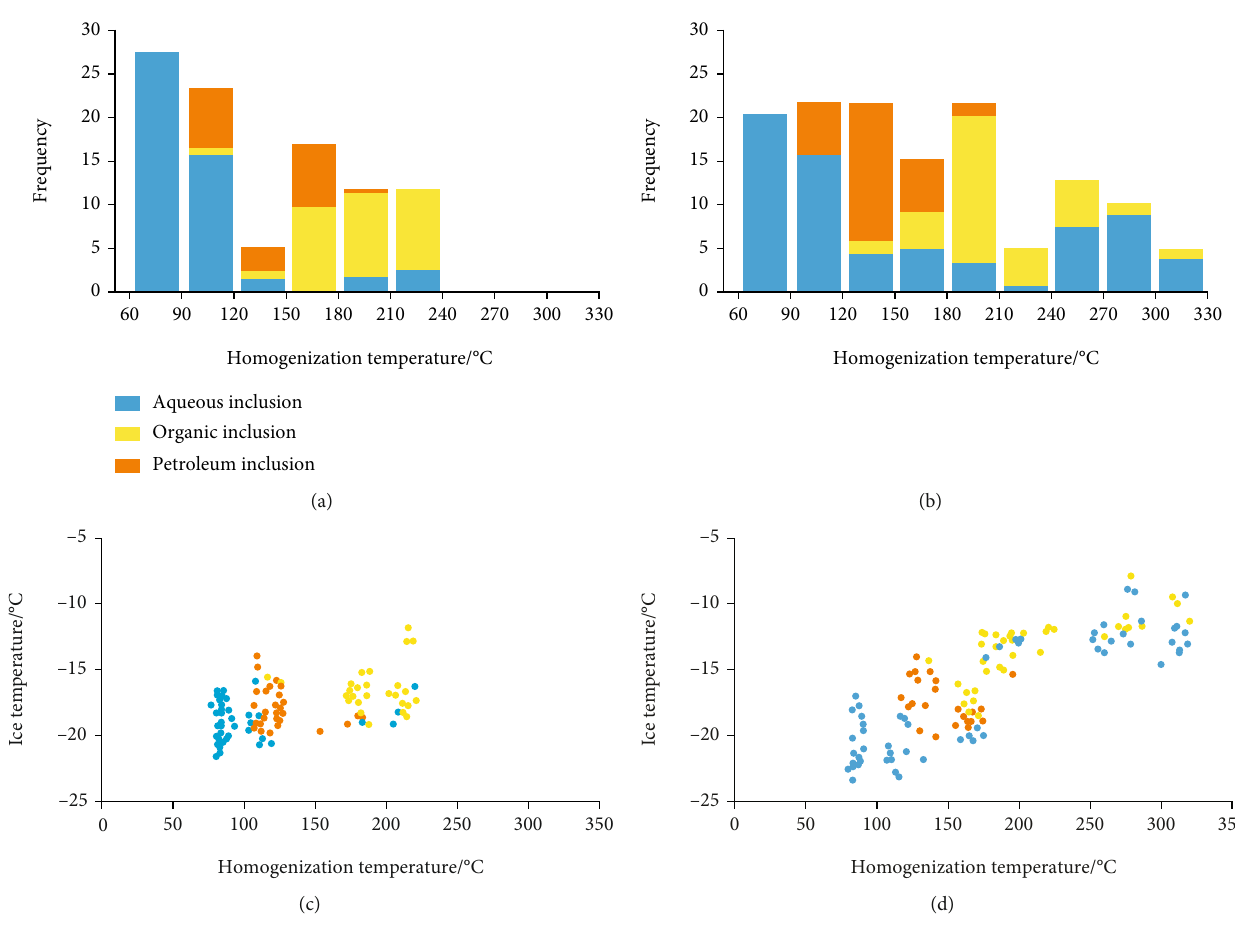
Figure 8: Relationship between homogenisation temperature and salinity of fl uid inclusions. (a) Frequency histogram of homogenisation temperature for CS well #1; (b) frequency histogram of homogenisation temperature for MS well #1; (c) uniform-temperature salinity diagram of CS well #1 inclusions; (d) uniform-temperature salinity diagram of MS well #1